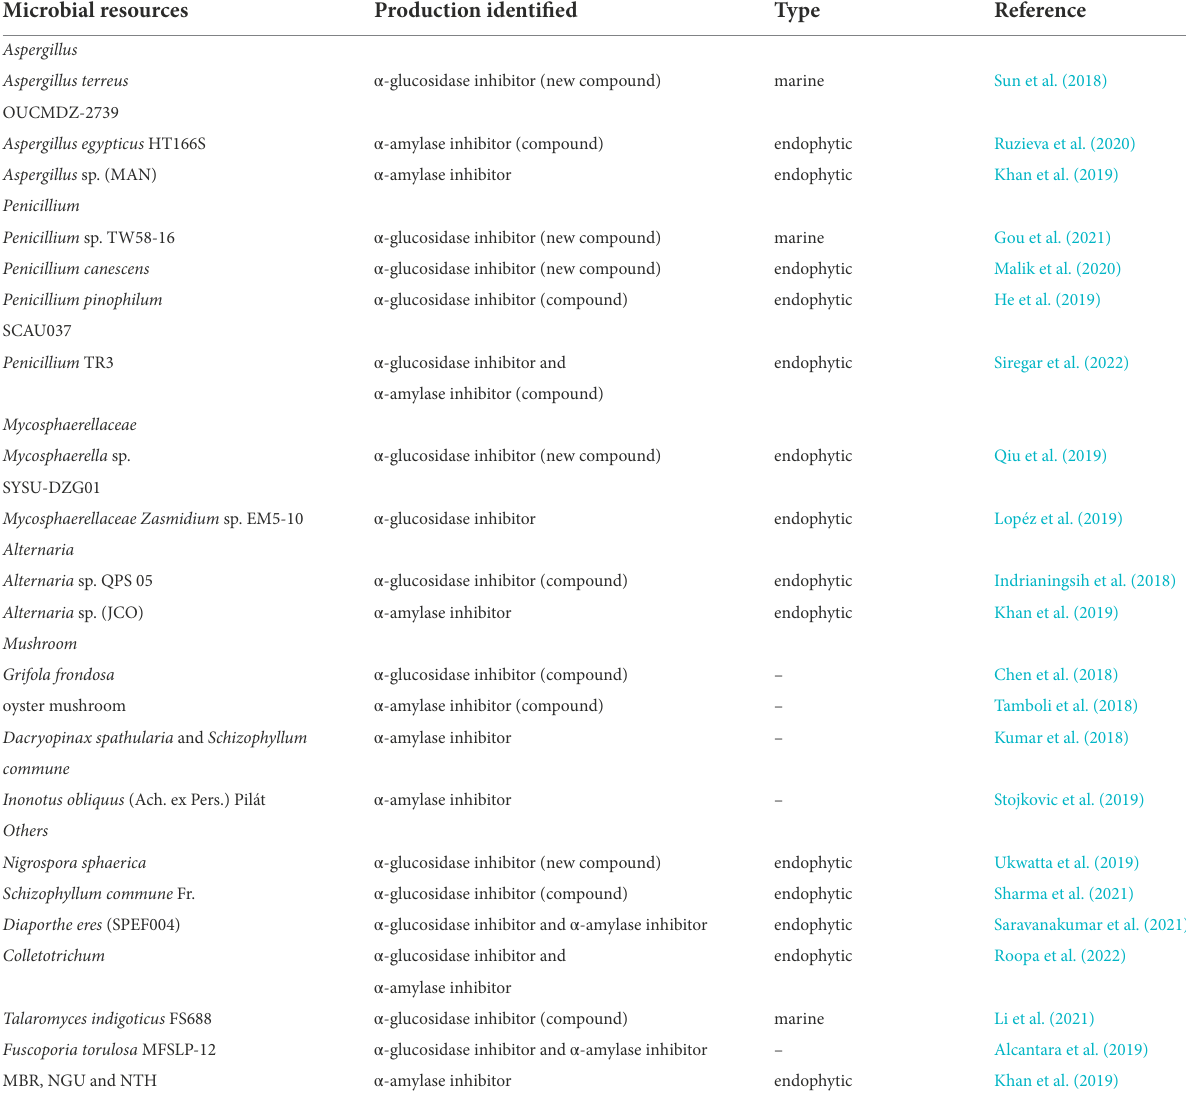
TABLE 2 Fungus with inhibitory activity against glycosidase in recent 5